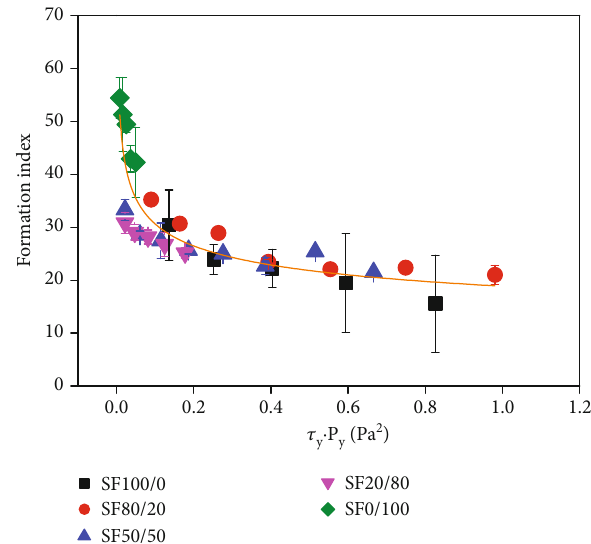
Figure 6: Formation index of meta-aramid papers as a function of τ ⋅ P y y